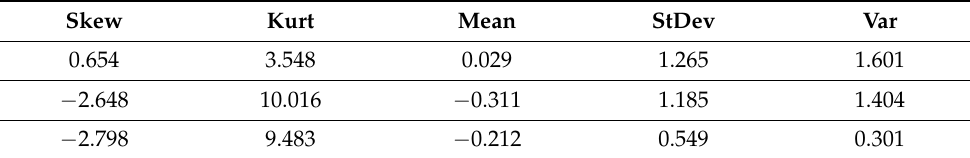
Table 8. The residual analysis for the developed ANN